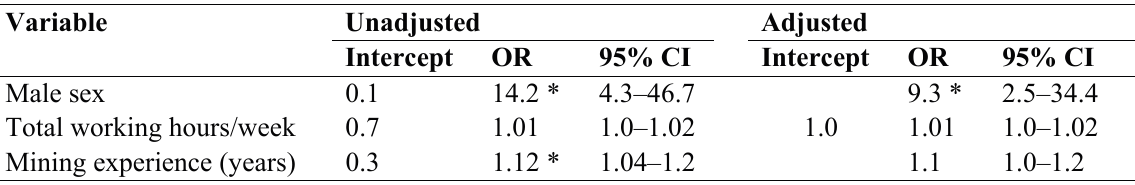
Table 4. Binary logistic regression model predicting odds ratio (OR) for past-year injury in 2011 (N = 69